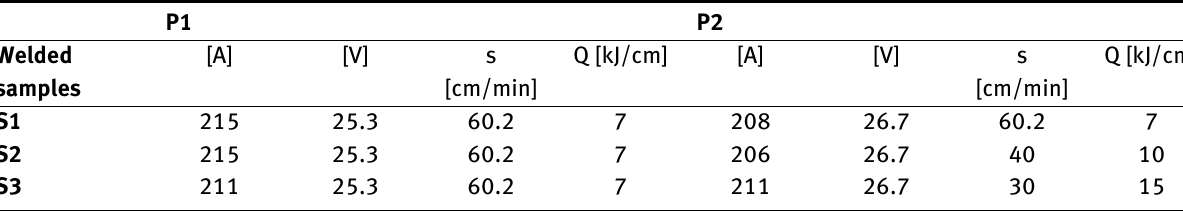
Table 2: AHSS/UHSS Welding conditions P1 P2 Welded